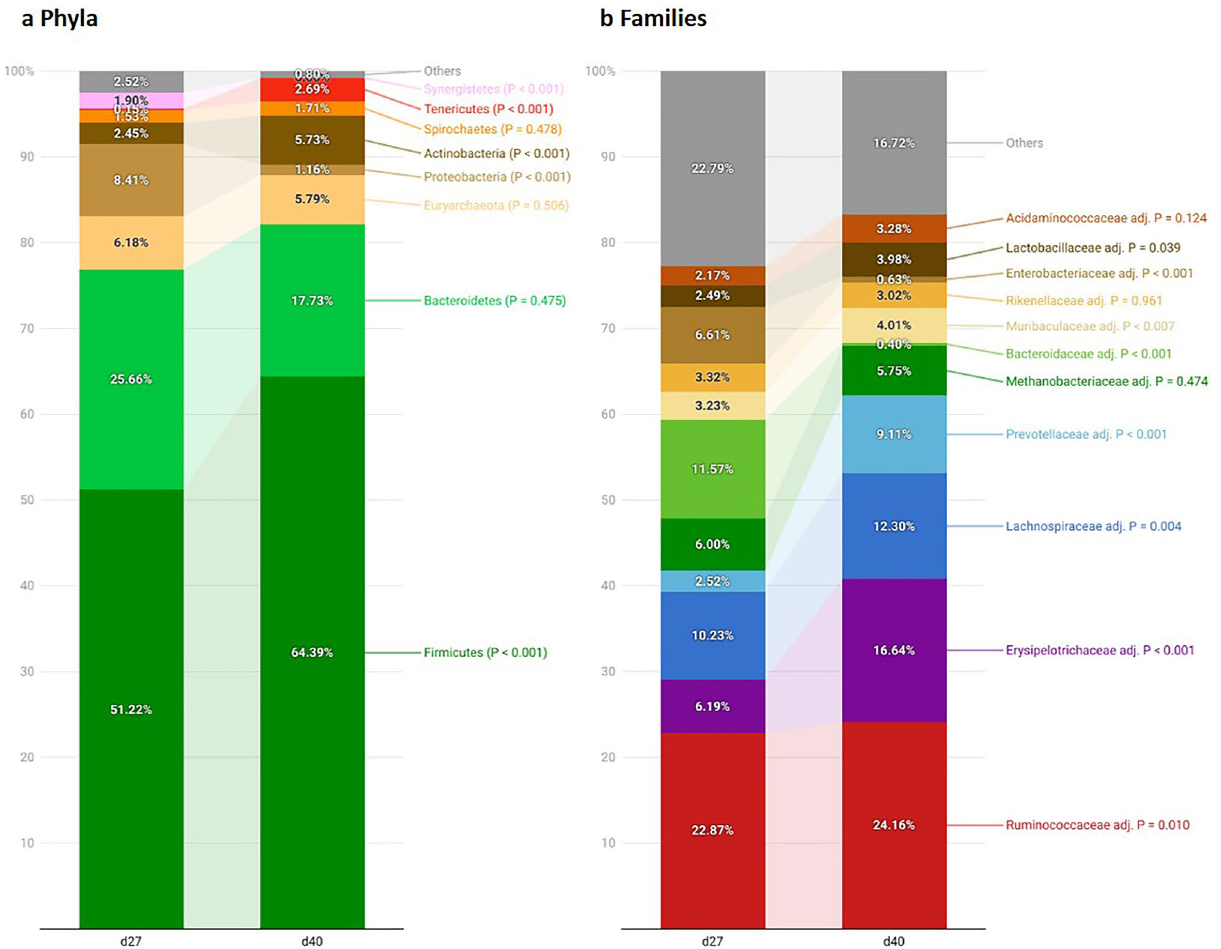
tool Datawrapper (http:// dataw rapper.